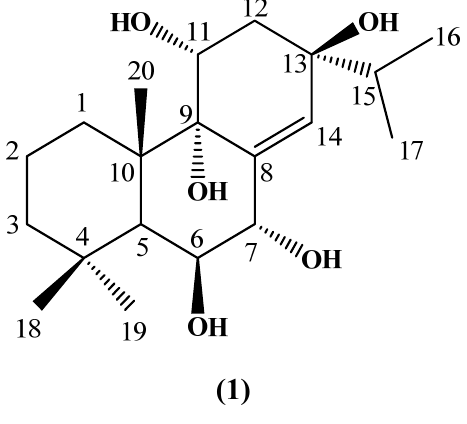
Figure 1. Structures of